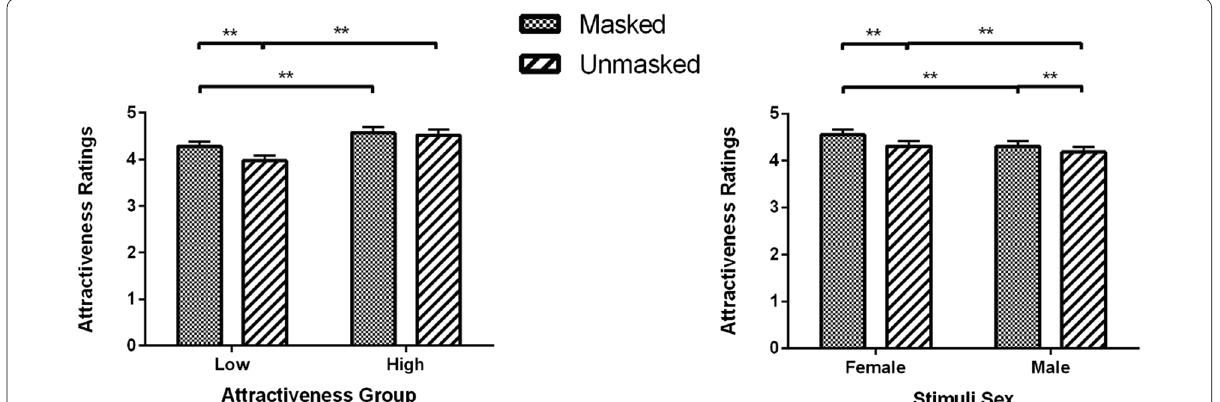
Fig. 2 Attractiveness ratings (Means and SEM) for masked and unmasked young faces as a function of attractiveness group and stimuli sex. * p < 0.05, ** p <